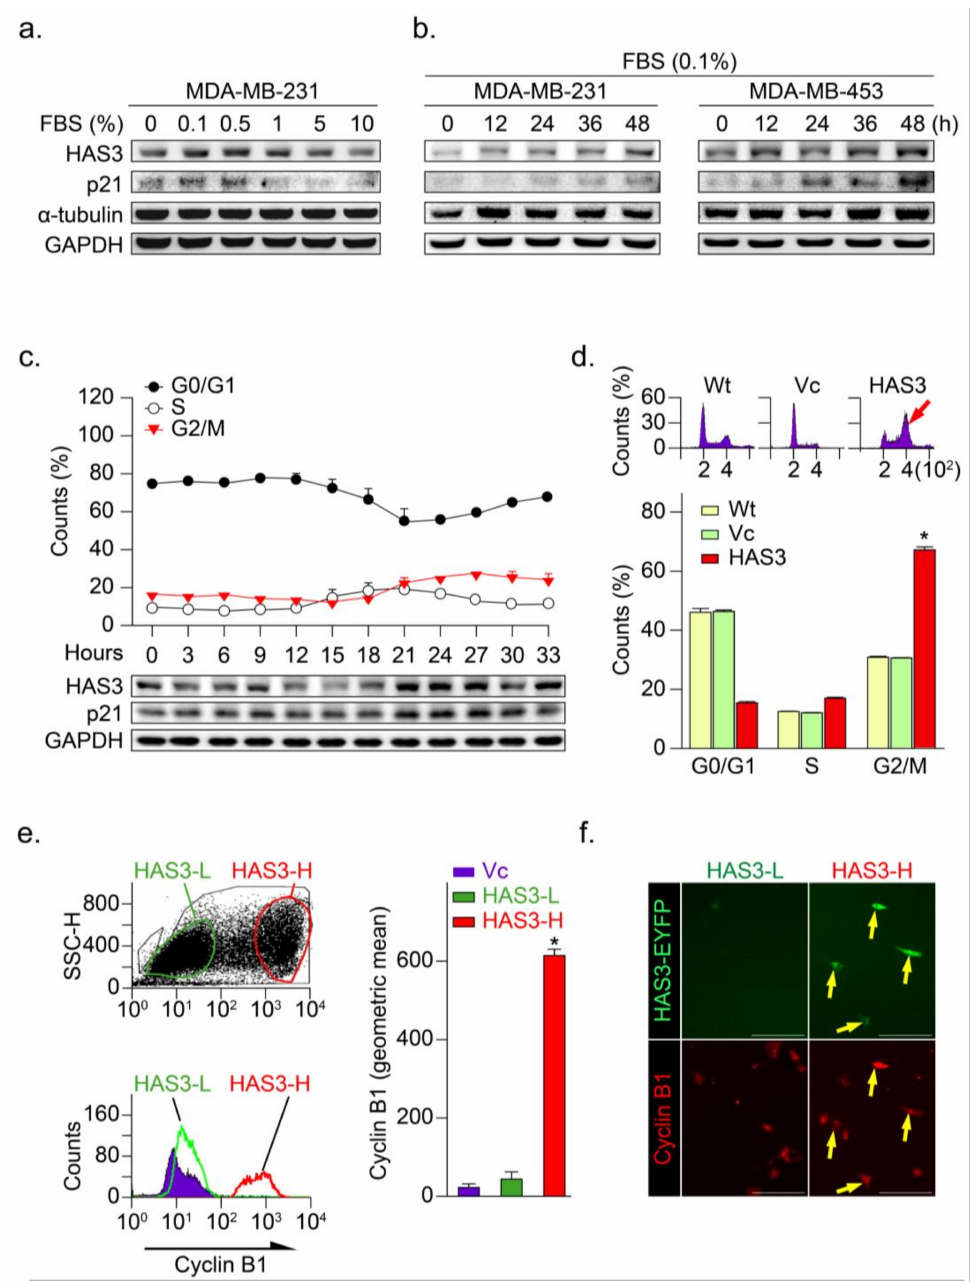
Figure 3. HAS3 overexpression arrested human breast cancer cells at the G2/M phase cell cycle. ( a ) MDA-MB-231 cells were treated with media containing serum at different concentrations (0–10%) for 24 h and harvested to detect the protein levels of HAS3, p21, α -tubulin, and GAPDH by Western blot analysis; ( b ) The protein levels of HAS3, p21, α -tubulin, and GAPDH were detected by Western blot analysis in breast cancer cells (MDA-MB-231 and MDA-MB-453), after being treated with 0.1% FBS for 12–48 h; ( c ) Flow cytometry analysis of MDA-MB-231 cells was performed, and the fraction of cells at G0/G1, S, and G2/M phase was assessed by PI staining (upper panel). The protein levels of HAS3, p21, and GAPDH were detected by Western blot analysis. The data are presented as the mean ± SD relative to the cell population (%); ( d ) HAS3 overexpression in MDA-MB-231 cells arrested cell proliferation at the G2/M phase of the cell cycle. Representative flow cytometry histograms showing alterations in the cell cycle of MDA-MB-231 cells 24 h after transfection. The data are presented as relative to the cell population (%). Data were analyzed with a paired t-test,